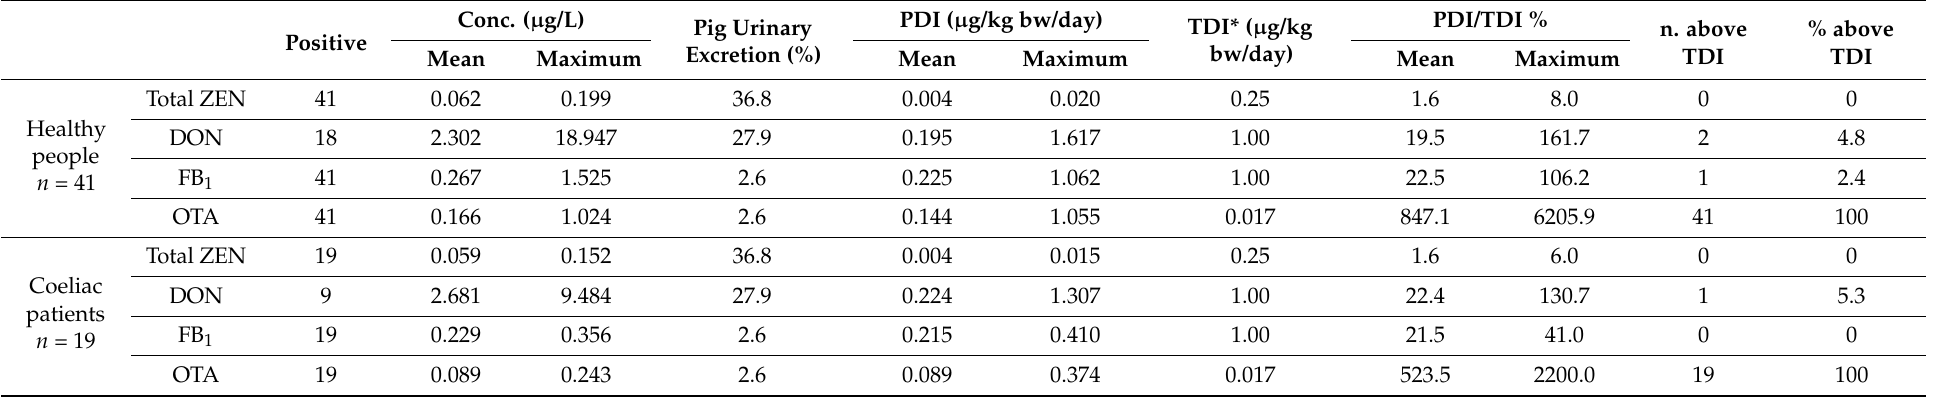
Table 4. Mean and maximum concentration of mycotoxins in human urine samples collected in Hungary from healthy people and coeliac patients and estimated PDI values based on the urinary excretion rate for piglets [10].